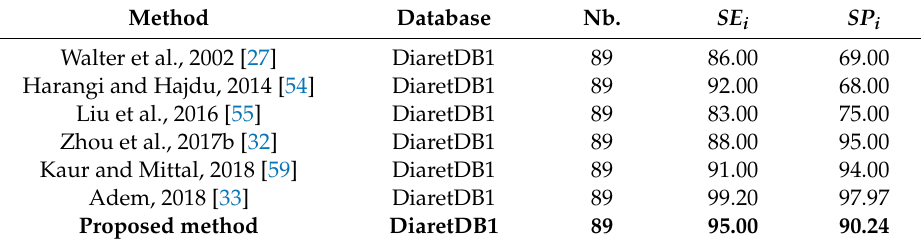
Table 5. Comparison of some methods for exudate